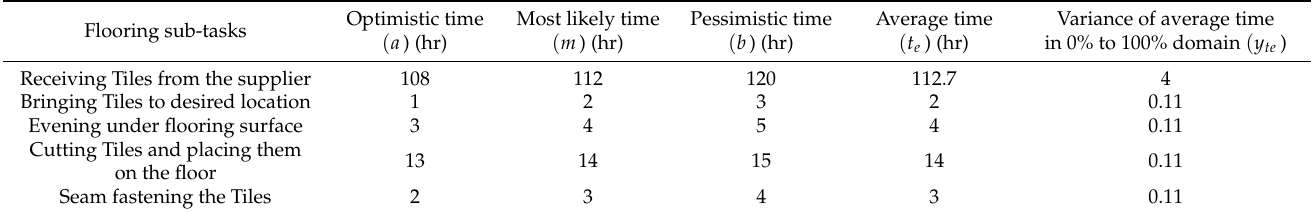
Table 13. Beta distribution with three parameters for sub-tasks of flooring.